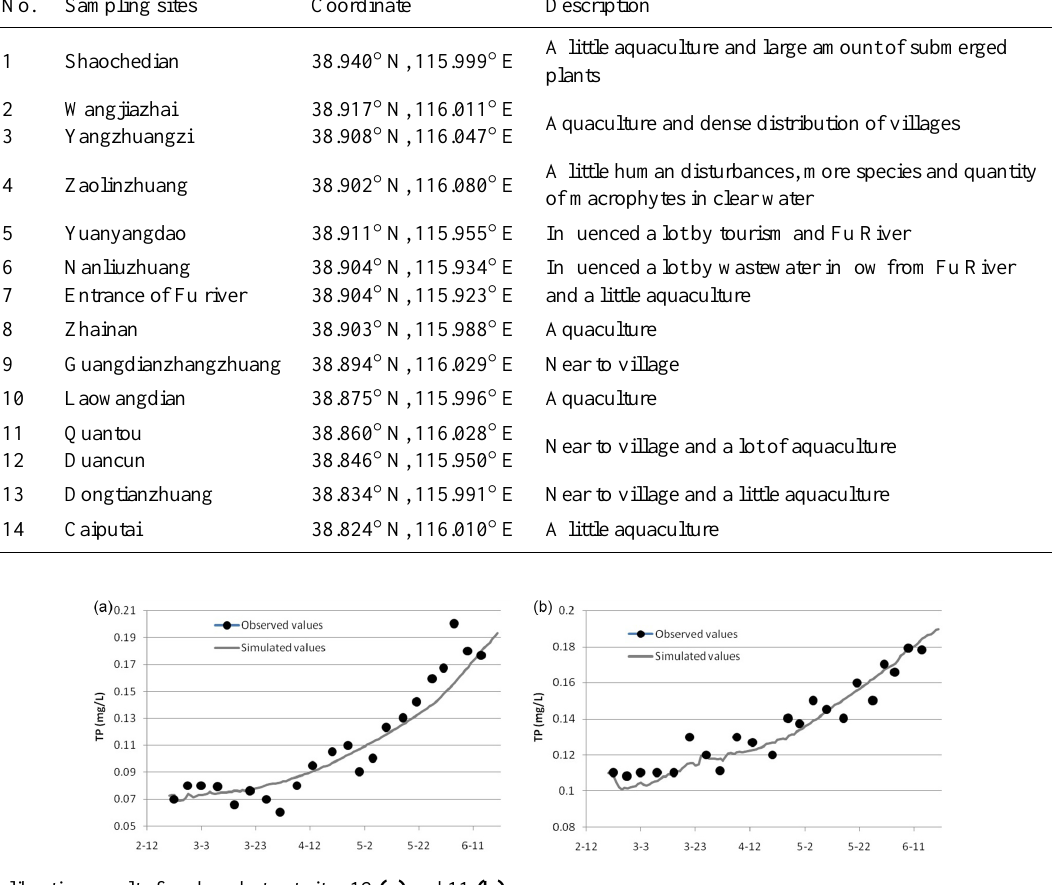
of Baiyangdian Lake has gradually disappeared with severe negative effects on the health and sustainable development of the lake